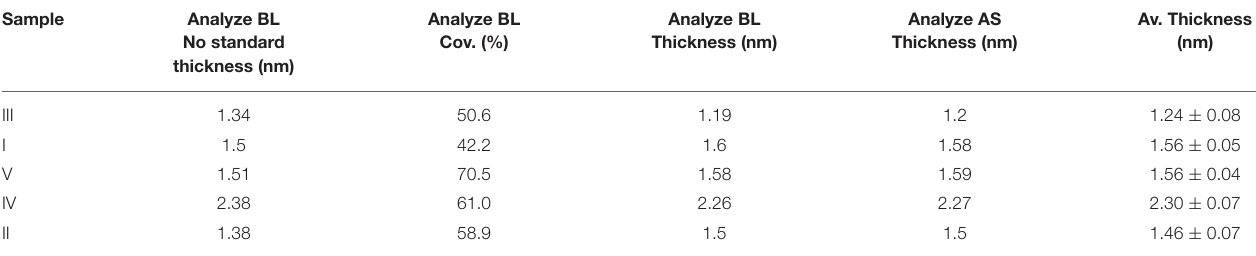
TABLE 2 | Coverage and overlayer thickness resulting from QUASES-Analyze Buried Layer (BL) model without a standard, and BL and Active Substrate (AS) models with a Fe 3 O 4 standard.